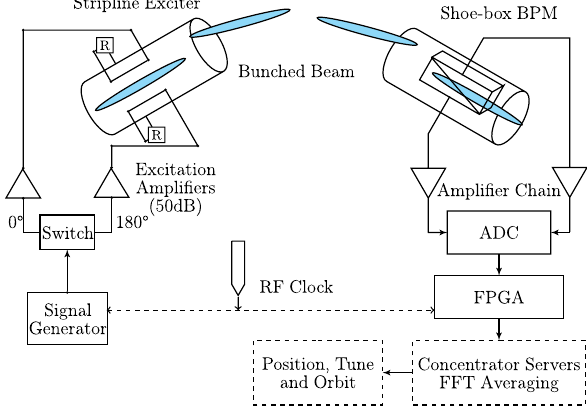
FIG. 6. Scheme of the excitation system and the tune, orbit and position (TOPOS) measurement